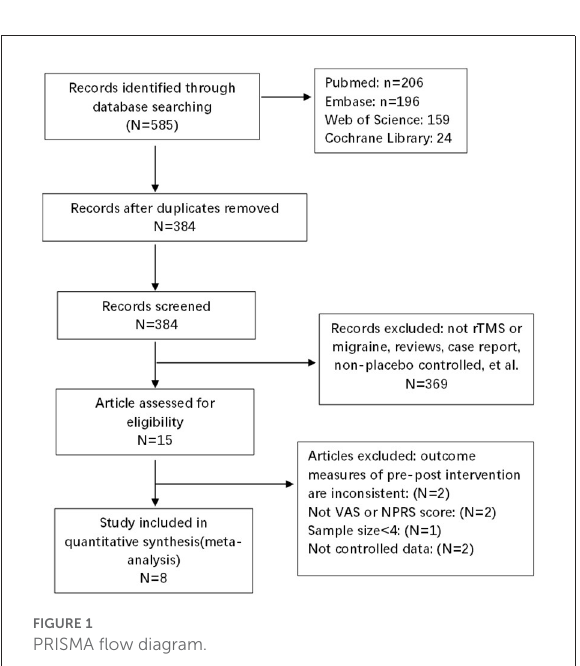
FIGURE1 PRISMA flow